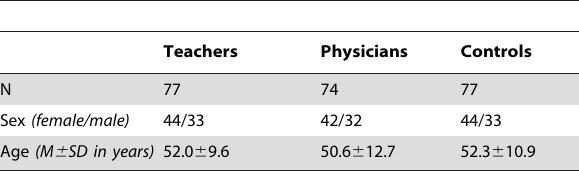
Table 2. Characteristics of teachers, physicians and control participants